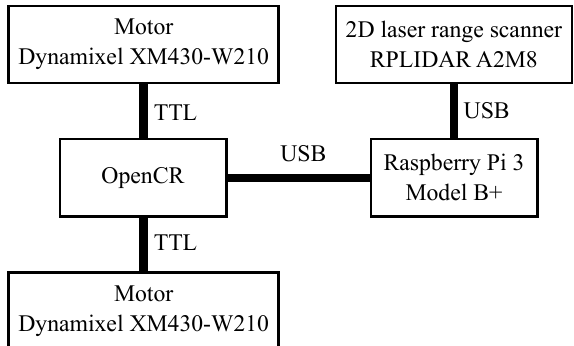
Figure 3. Window scanning robot. The robot’s size is 189.7 × 138.7 × 191.9 mm, and its weight is 1.26 kg. The robot can obtain location information of window frames using a 2D laser range scanner installed perpendicularly to the ground.